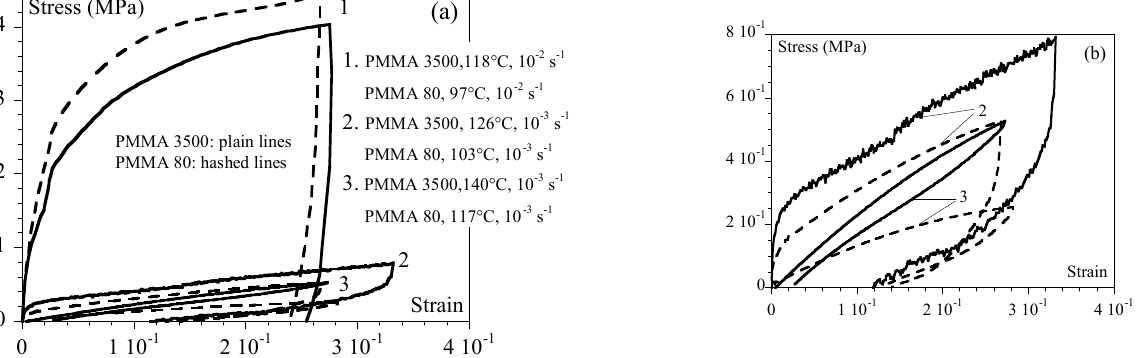
Figure 3. Comparison between PMMA 3500 (plain lines) and PMMA 80 (hashed lines) for similar equivalent strain rates at T_ α : (1) PMMA 3500—118 °C and 0.01 s − 1 and PMMA 80—97 °C and 0.01 s − 1 ; (2) PMMA 3500—126 °C and 0.001 s − 1 and PMMA 80—103 °C and 0.001 s − 1 ; (3) PMMA 3500—140 °C and 0.001 s − 1 and PMMA 80—117 °C and 0.001 s − 1. Equivalent strain rates are given in Table 2. ( b ) Zoom of ( a ) for better visibility. Table 3. Comparison of PMMA 3500 and PMMA 80 in equivalent states. Experimental conditions as used in Figure 3 and with the associated equivalent strain rate at T α